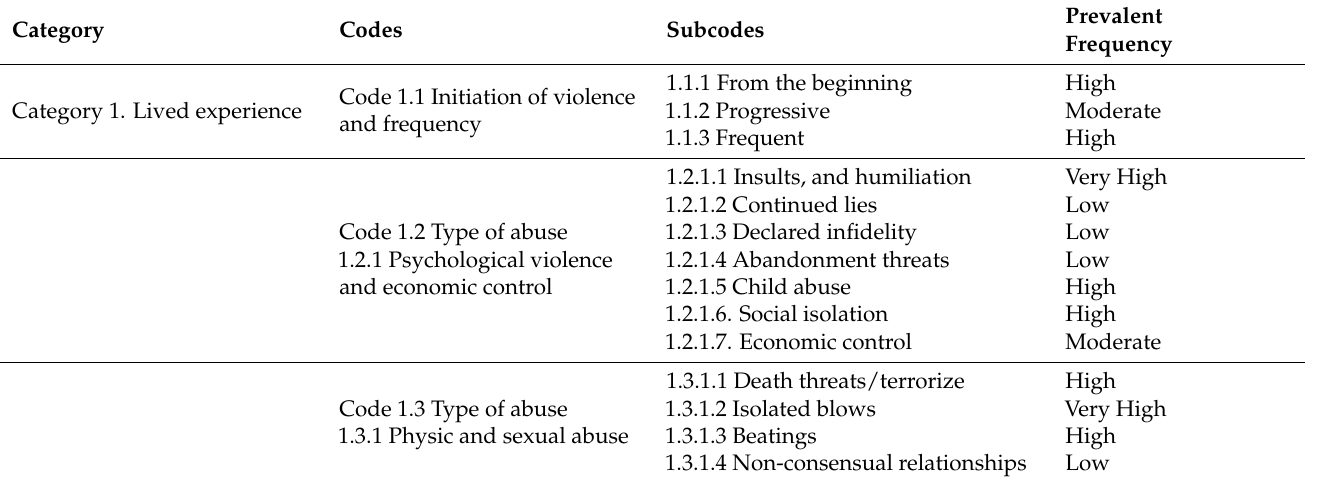
Table 1. Category